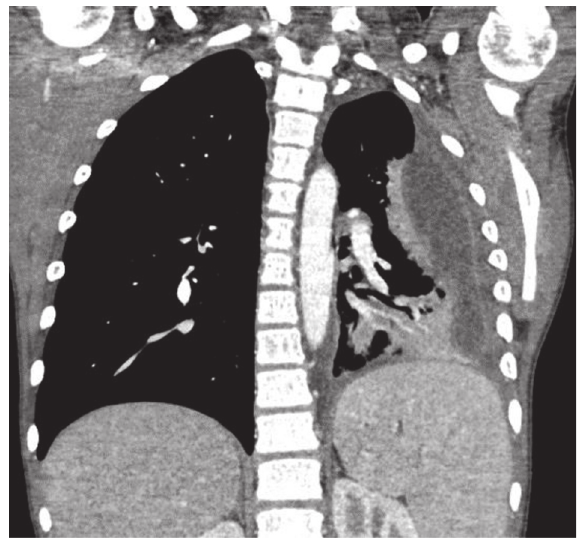
Figure 1: Volume loss noted in the left lung with large loculated fluid collection in the left pleural